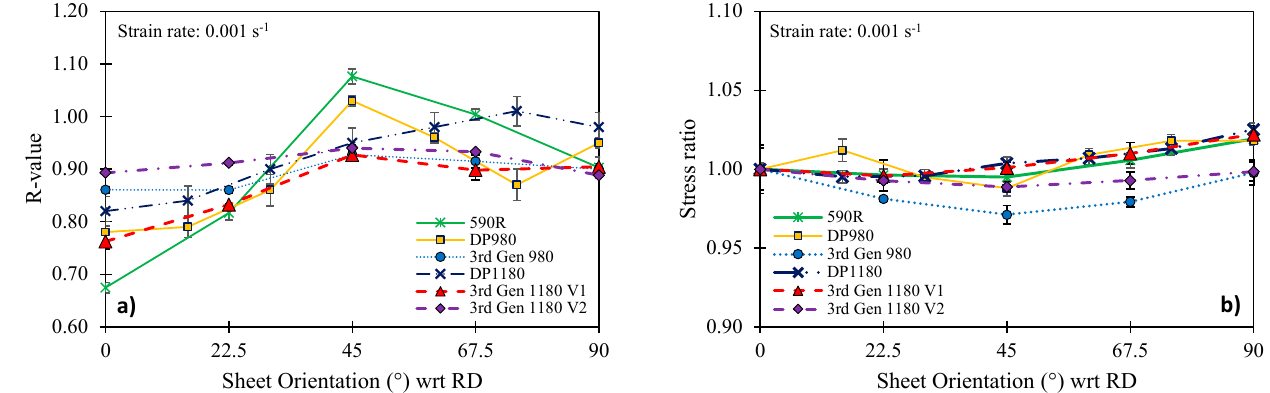
Figure 6. Comparison of R-value ( a ) and stress anisotropy ( b ) for the studied steel grades.